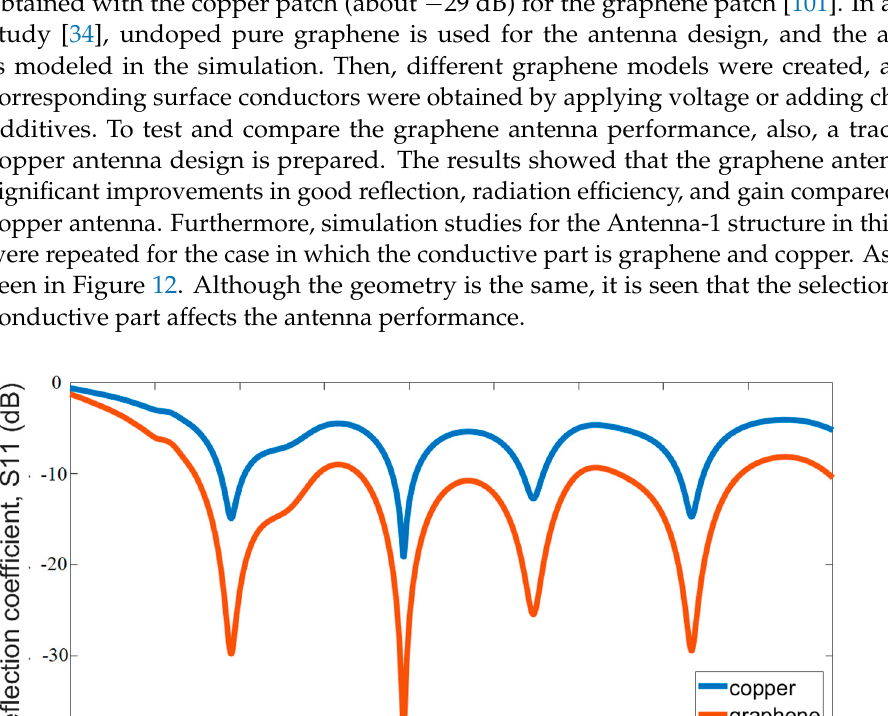
Table 5. Comparison of the manufactured antenna with some studies.